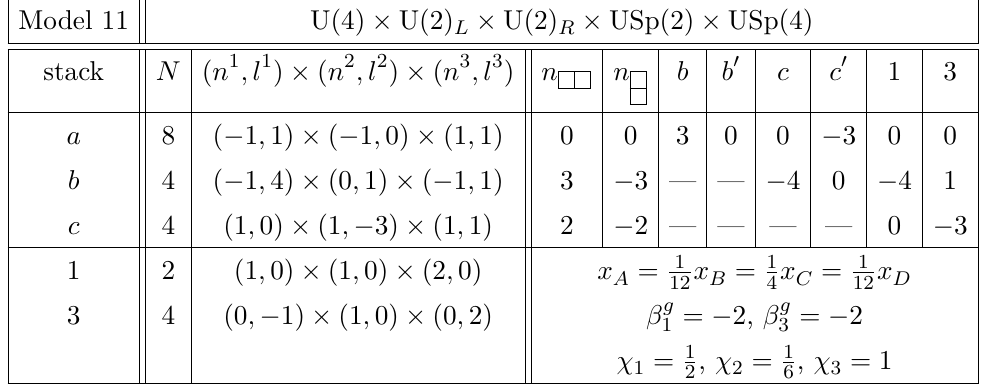
Table 18 . D6-brane configurations and intersection numbers of Model 11, and its MSSM